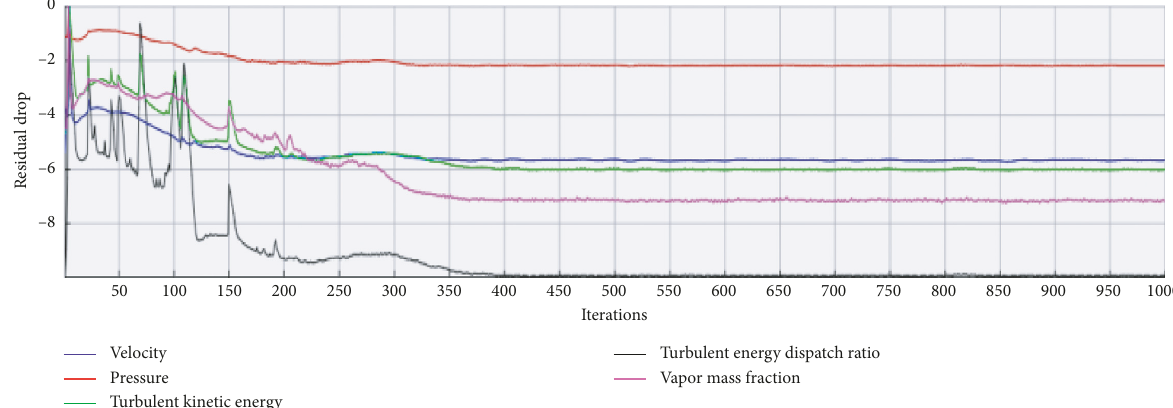
Figure 3: Residual